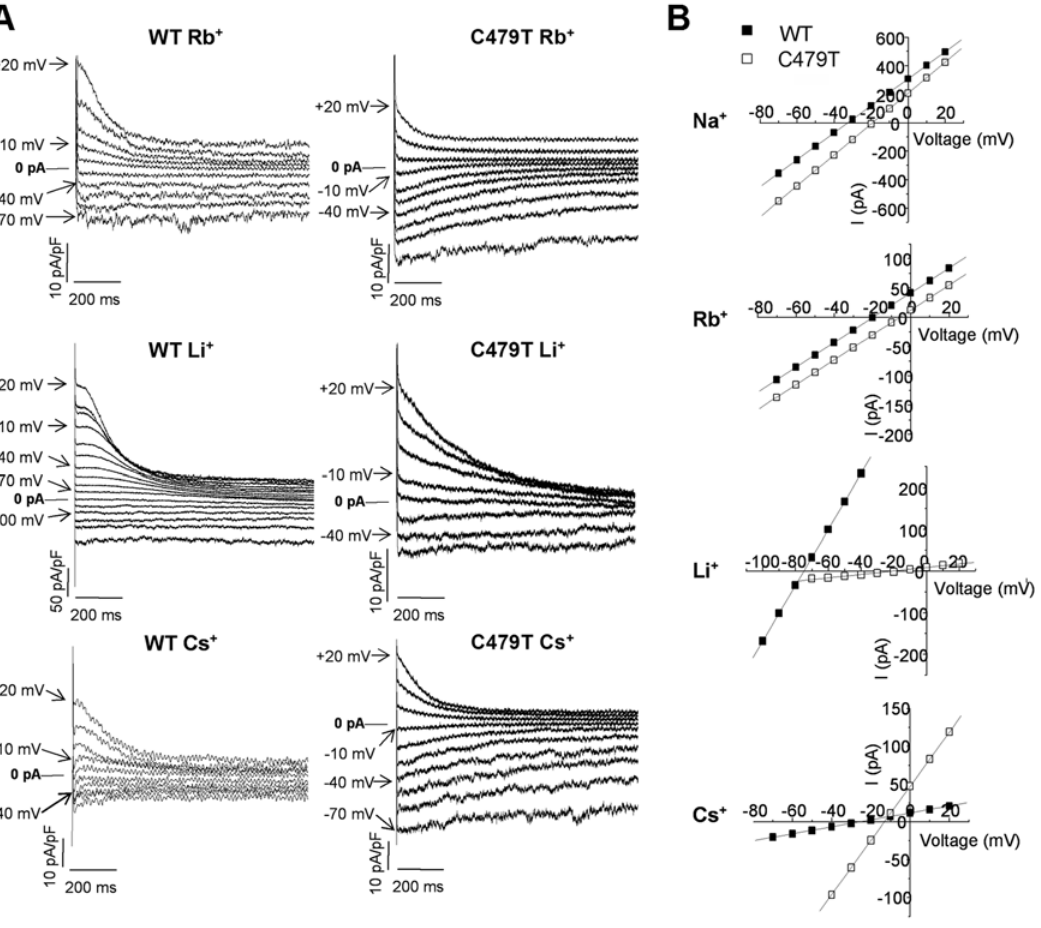
Figure 2. E rev ’s determined from the instantaneous I–V relationship. (A) Sample tail currents elicited following an activating ‘‘pre-pulse’’ to 2 130 mV as shown in Figure 1B for experiments performed in 5 mM K + and 135 mM X + (Li + , Rb + , Cs + ) extracellular bath solution. (B) Representative instantaneous I–V relationships for recordings performed in 5 mM K + and 135 mM X + (Na + , Li + , Rb + , Cs + ) bath solution WT ( & ) and C479T ( % ) channels. E rev ’s were determined from the linear fits of the I–V relationship for each cell, and were then used to calculate the P X /P K using the GHK equation and averaged as presented in Table